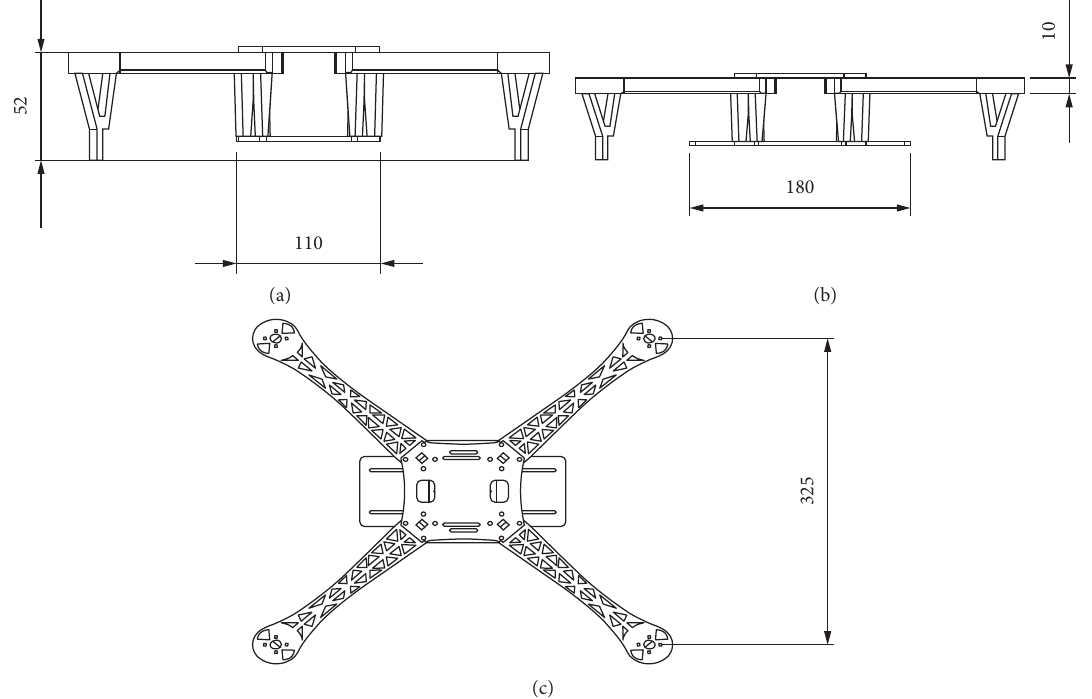
Figure 4: (a) UAV frame side view, (b) UAV frame with base measurement, and (c) UAV frame top view.